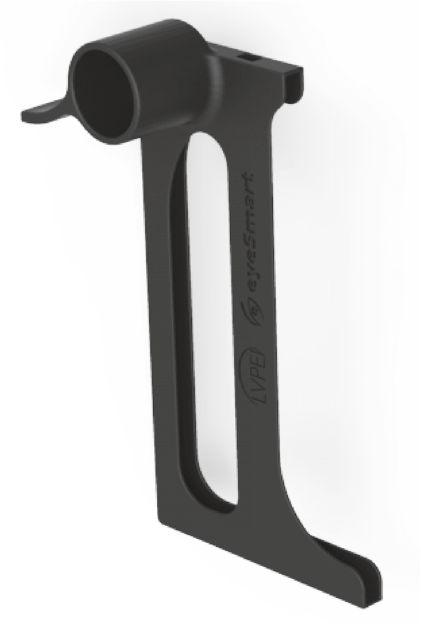
Figure 1: CAD design of eyeSmart Cyclops.